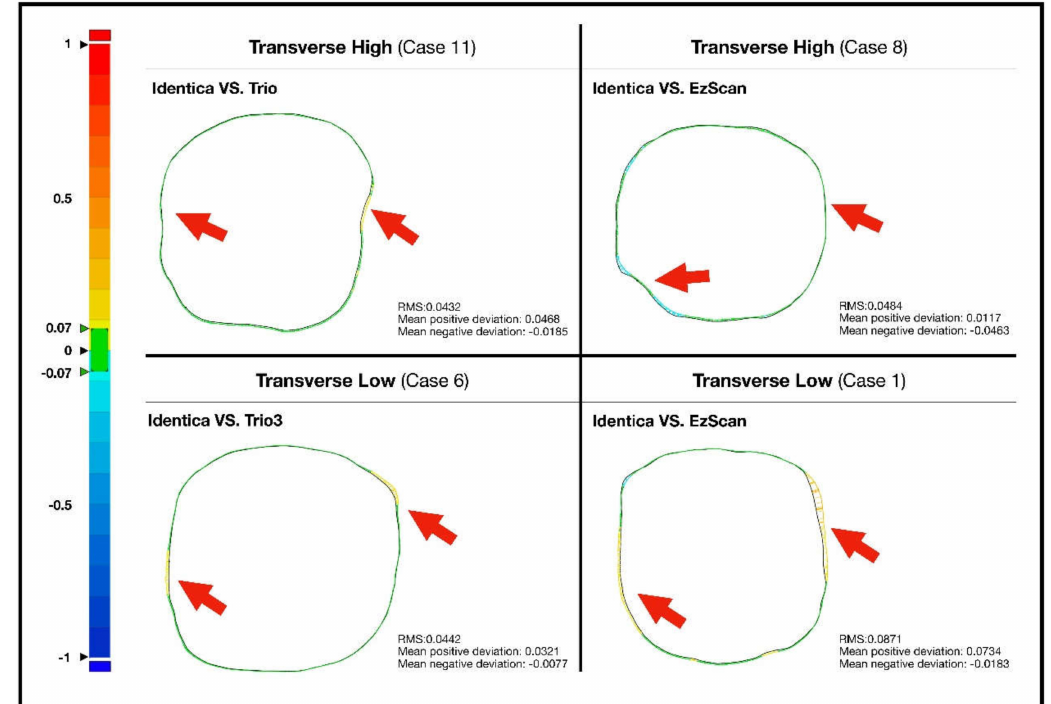
Figure 5. Sharp edges and rough areas on prepped surfaces showed high deviation errors. Red arrows indicate pronounced